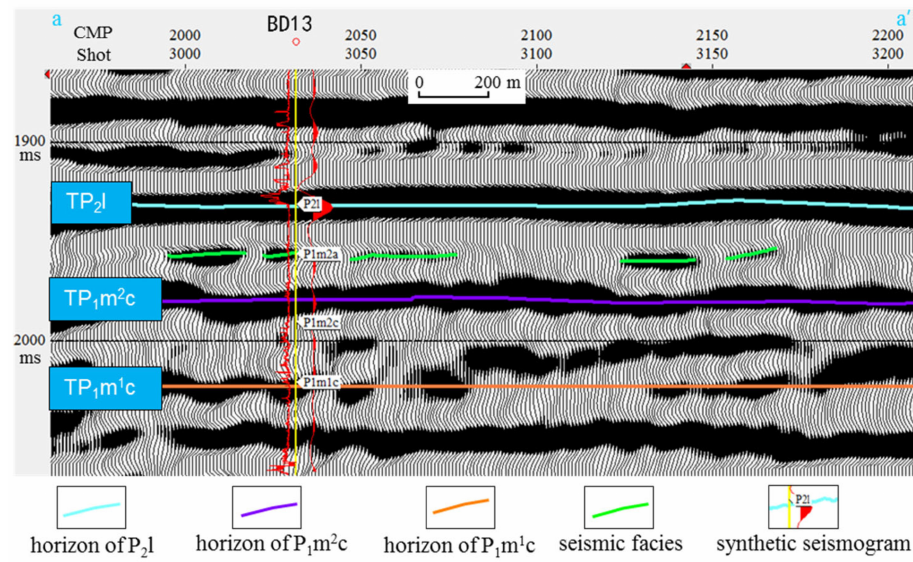
Figure 7. Seismic facies of imbricate progradation (seismic line through Well BD13).